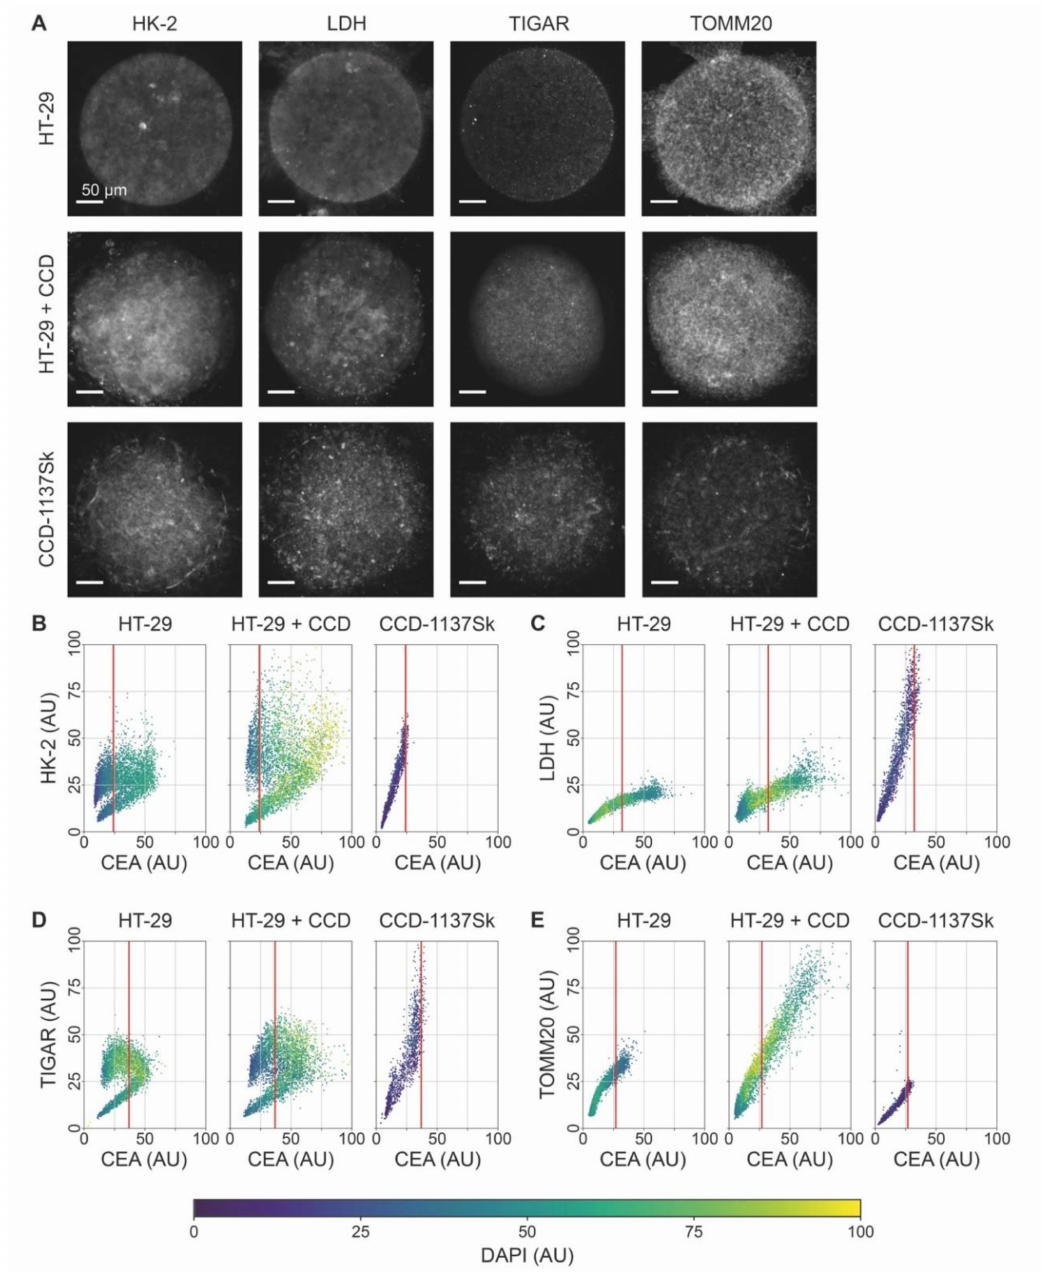
Figure 7. The expression of relevant metabolic marker proteins is altered upon co-culturing of HT-29 and CCD-1137Sk cells in Dynarrays. A total of 4000 cells per chip cavity were seeded to yield either mono- or co-cultures of HT-29 and CCD-1137Sk cells. In the case of co-cultures, 2000 HT-29 cells were co-seeded with 2000 CCD-1137Sk cells per well. After four days, chips were fixed, cleared, and stained with DAPI and antibodies against CEA as well as HK-2, LDH, TIGAR, or TOMM20 as markers for nuclei, cancer cells, and di ff erent metabolic activities, respectively. Then, samples were imaged with 3-D confocal microscopy. ( A ) Representative sum-z projections. ( B – E ) Scatter plots showing the fluorescence intensity distributions of anti-HK-2 ( B ), anti-LDH ( C ), anti-TIGAR ( D ), or anti-TOMM20 ( E ) as a function of the anti-CEA intensity for HT-29 mono-cultures (left), HT-29 + CCD-1137Sk co-cultures (middle), and CCD-1137Sk mono-cultures (right). Each dot shows the average intensity of a voxel cube in a total of five Dynarray cavities. Red vertical line, CEA brightness range that contains 95% of all CCD-1137Sk voxel cubes in